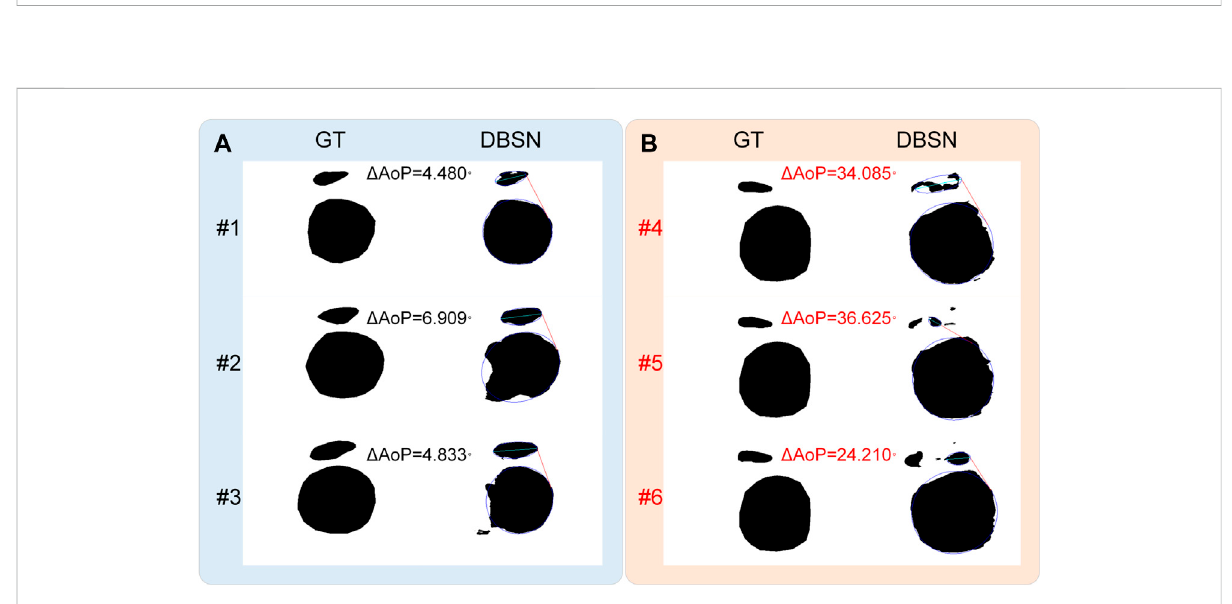
FIGURE 5 Effects of incorrect results on the AoP measurement. (A) Incorrect segmented results (#1, #2 and #3) have little effect on the determination of the three points, leading to a smaller Δ AoP ( < 20 ° ). (B) Incorrect segmented results (#4, #5 and #6) have a signi fi cant impact on the determination of any of the three points, resulting in a larger Δ AoP ( > 20 °